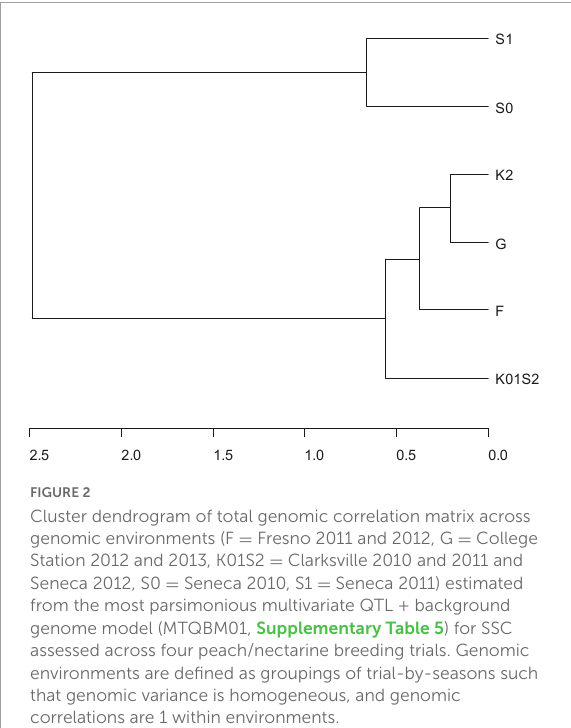
FIGURE2 Cluster dendrogram of total genomic correlation matrix across genomic environments (F = Fresno 2011 and 2012, G = College Station 2012 and 2013, K01S2 = Clarksville 2010 and 2011 and Seneca 2012, S0 = Seneca 2010, S1 = Seneca 2011) estimated from the most parsimonious multivariate QTL + background genome model (MTQBM01, Supplementary Table 5 ) for SSC assessed across four peach/nectarine breeding trials. Genomic environments are defined as groupings of trial-by-seasons such that genomic variance is homogeneous, and genomic correlations are 1 within